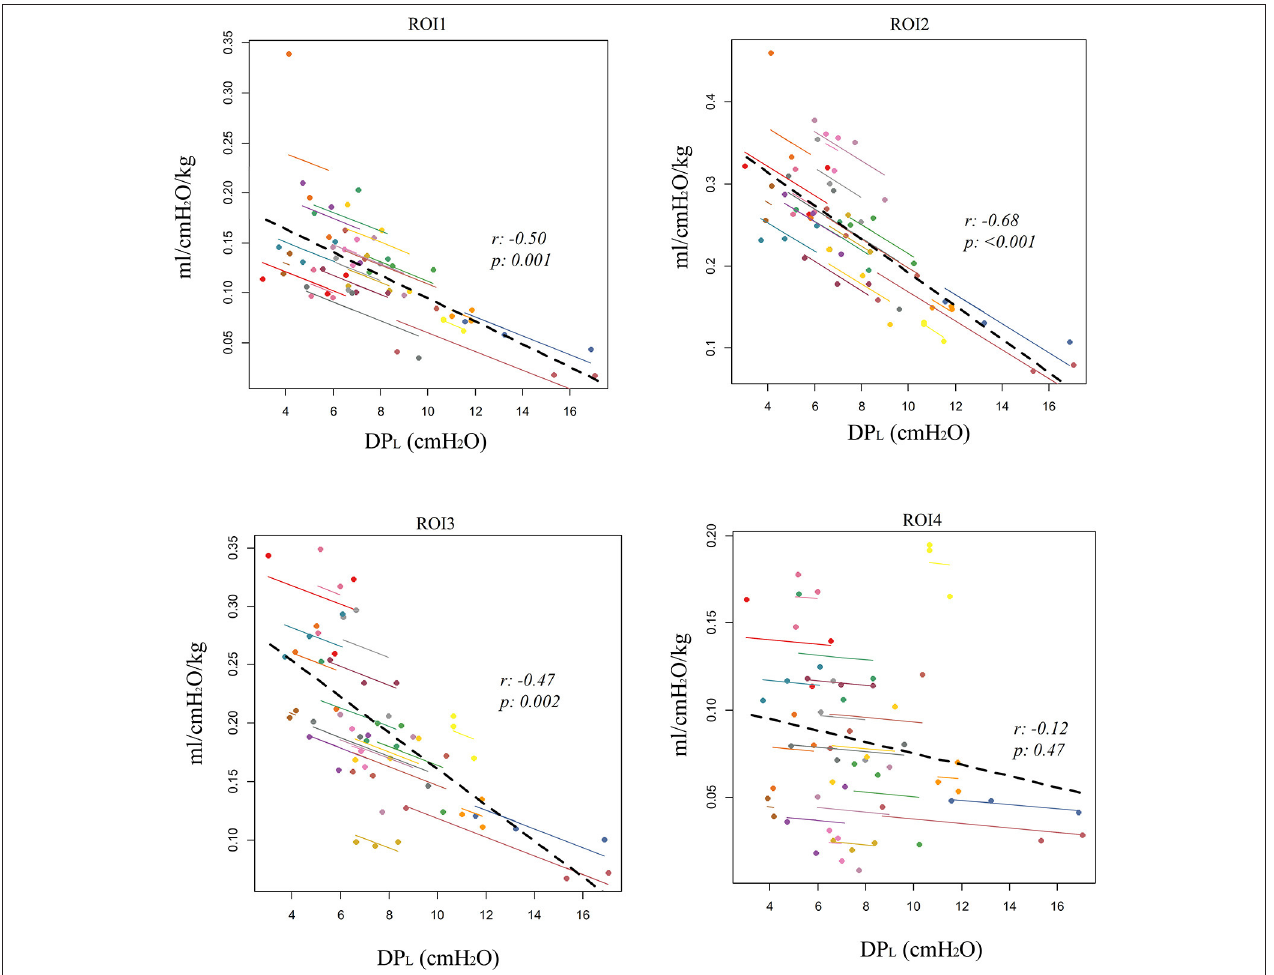
FIGURE 1 | Correlation between electrical impedance tomography (EIT)-derived regional compliance in the four craniocaudal regions of interest (ROI1, ventral lung; ROI4, dorsal lung) and esophageal-derived transpulmonary driving pressure (DP L ). Repeated measures correlation